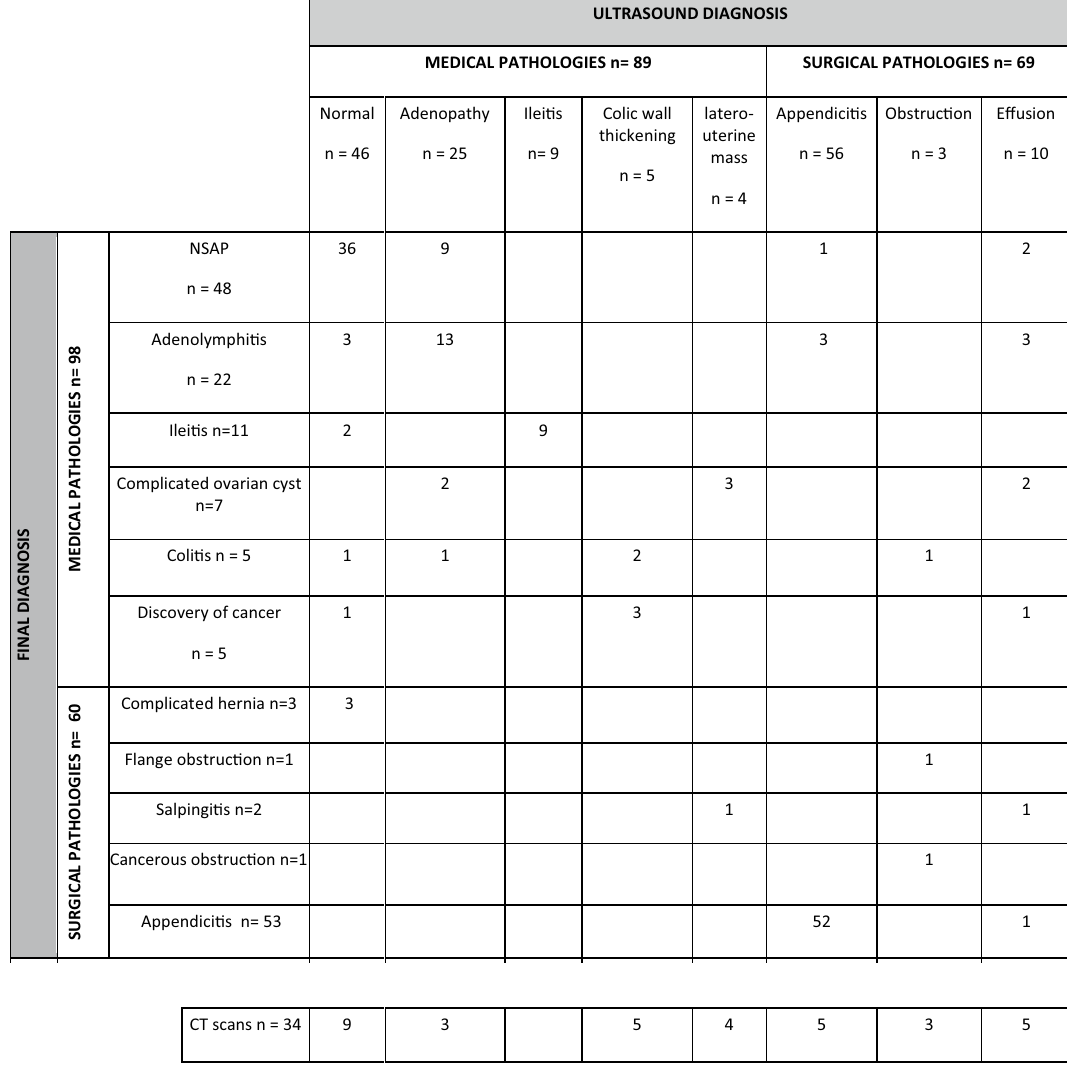
ULTRASOUND DIAGNOSIS MEDICAL PATHOLOGIES n= 89 SURGICAL PATHOLOGIES n=